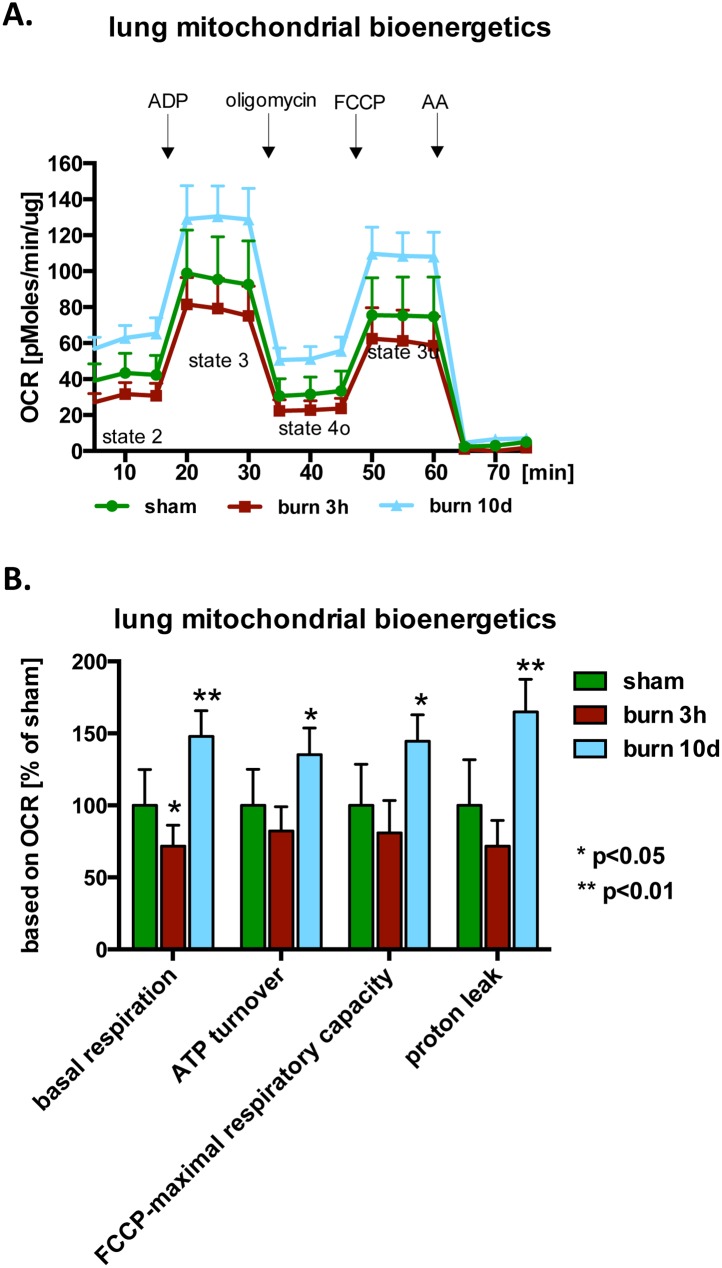
Burn injury induces time-dependent changes in the mitochondrial bioenergetics in the lung.Bioenergetic parameters of the isolated mitochondria from lungs of mice subjected to burn injury were analyzed by Extracellular Flux Analysis. (A) Traces of oxygen consumption of mitochondria isolated from sham or burn injured animals at various time points post burn injury are shown. (B) Calculated bioenergetics parameters are shown. The results are based on n = 6 per group and represent mean±SD. *, ** p<0.05 and p<0.01 respectively, relative to sham animals.